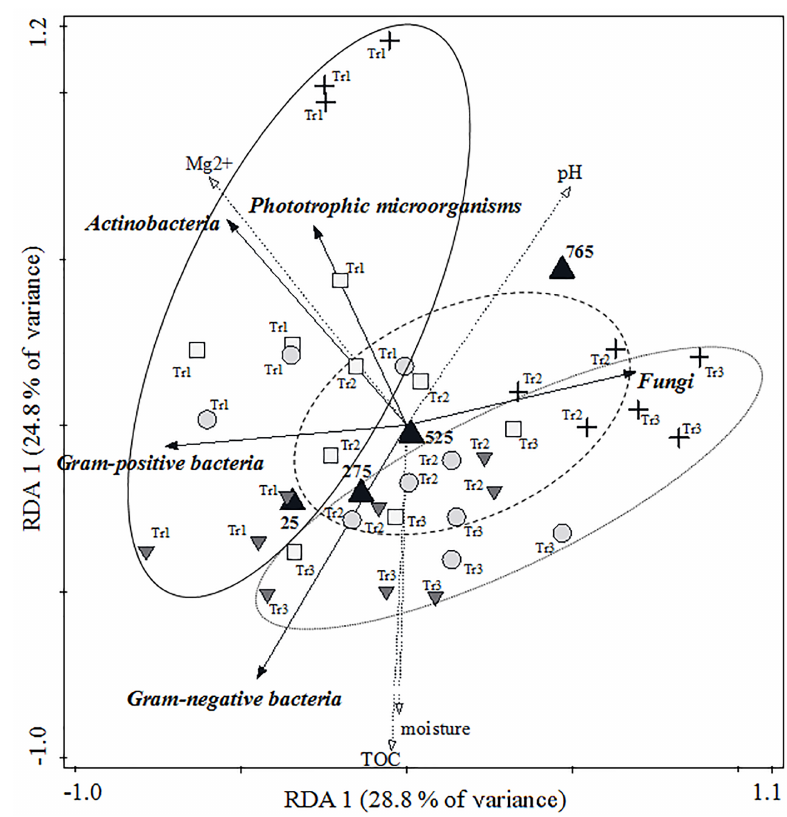
Figure 3. Correlation between the abundance of the main microbial groups (bold italic) and the soil geochemical parameters that were retained by forward selection from all explanatory variables collected. The altitude of sampling sites was used as a supplementary variable. Arrows indicate the direction in which the respective parameter value increases, solid lines indicate microbial groups, dotted lines indicate environmental variables retained by the forward selection procedure. Upright triangles are centroids of sites with corresponding elevation ( n = 9) and numbers indicate elevation (ma.s.l.). The thin solid line encases sites along Transect 1 (Tr1), the dashed line encases sites along Transect 2 (Tr2) and the dotted line encases sites along Transect 3 (Tr3). The downward triangles represent sites at 25ma.s.l., the circles represent sites at 275ma.s.l., the squares represent sites at 525ma.s.l., and the crosses represent sites at 765ma.s.l. The numbers in parentheses are the portions of the variation explained by each